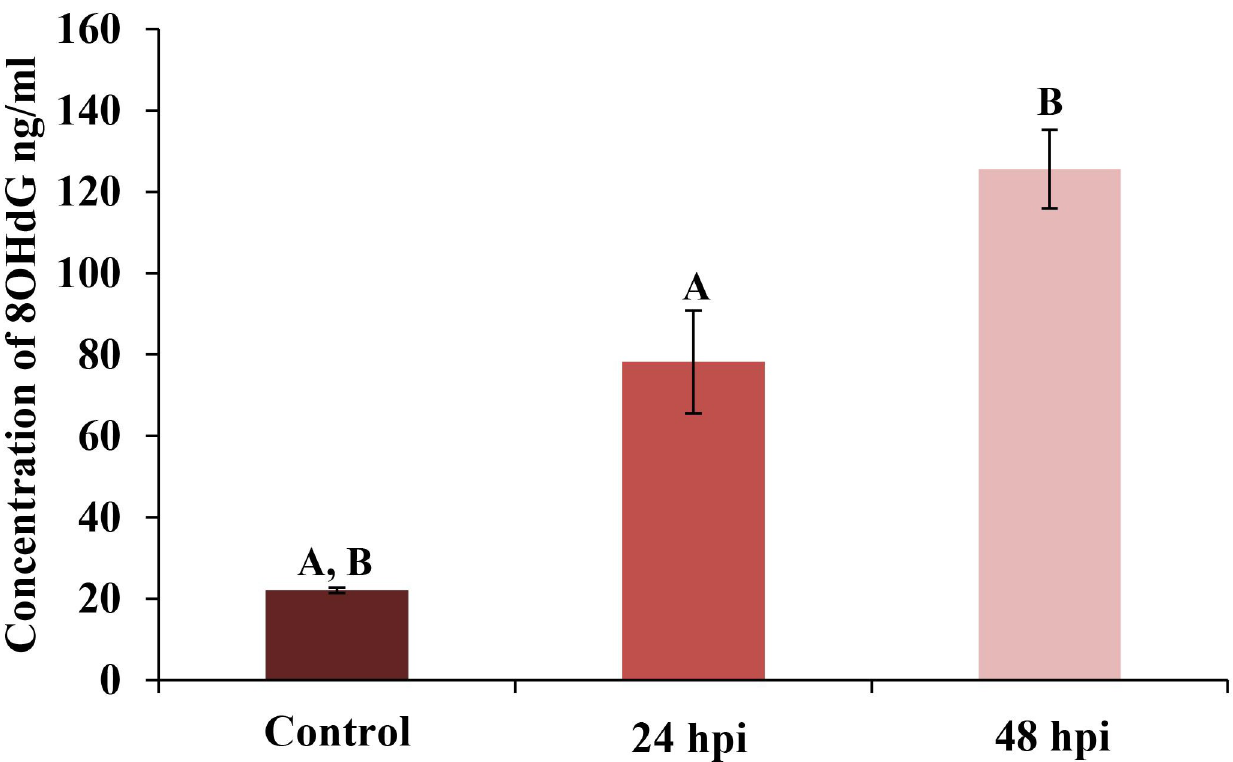
Fig 4. Determination the level of 8-hydroxy-2’-deoxyguanosine (8-OHdG) in hemolymph of Galleria mellonella larvae. Statistically significant differences are marked with the same letters (p < 0.05).